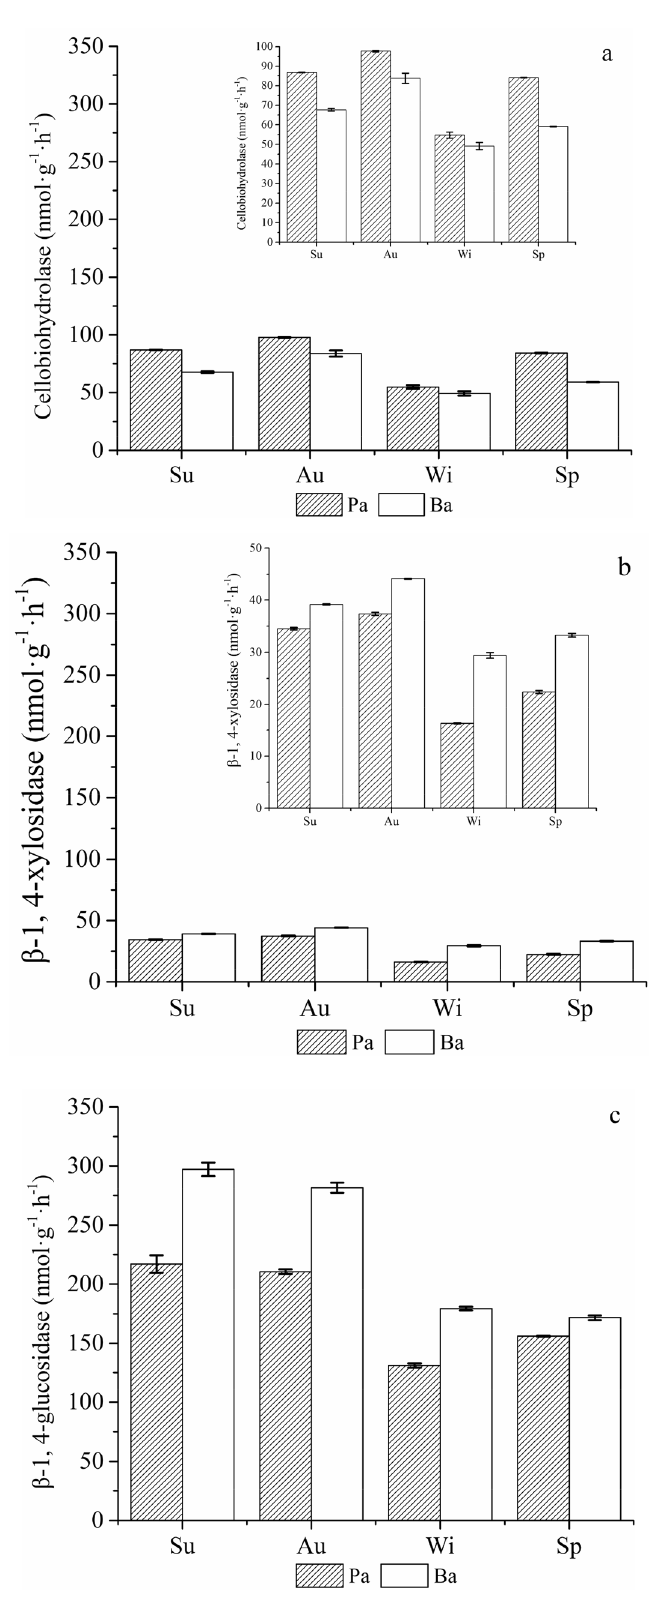
Figure 2. Changes in cellobiohydrolase ( a ), β-1,4-xylosidase ( b ), and β-1,4-glucosidase ( c ) in the four seasons. The error bars show standard errors. Sp, Su, Au and Wi represent spring, summer, autumn, and winter, respectively. Pa: Picea asperata Mast.; Ba: Betula albosinensis (this figure is made by Origin, version 9.0, 2012, OriginLab, Northampton, MA, USA; software available at: https ://www.origi